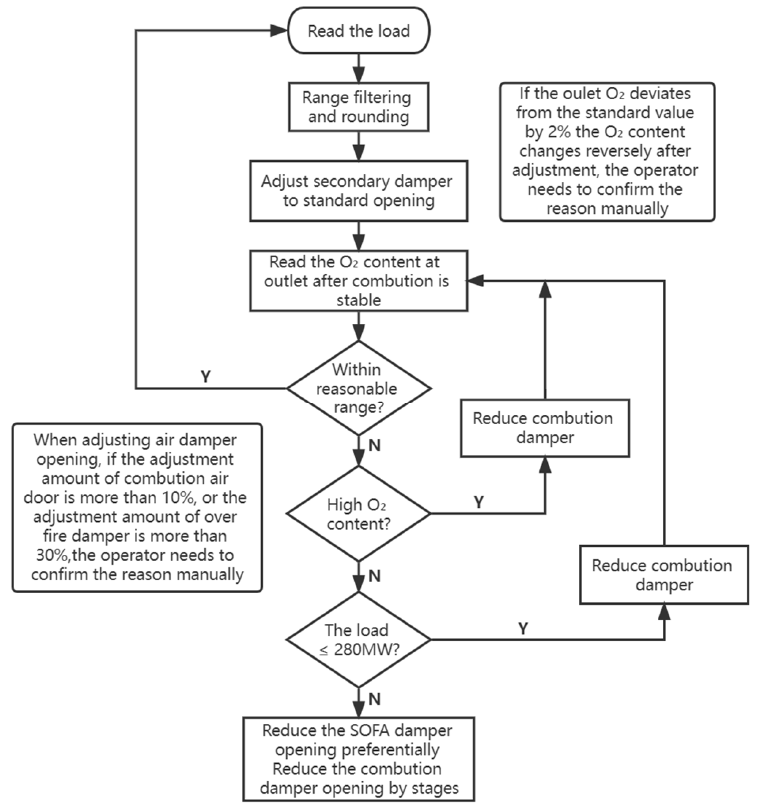
Figure 11. Flow chart of air distribution control strategy.